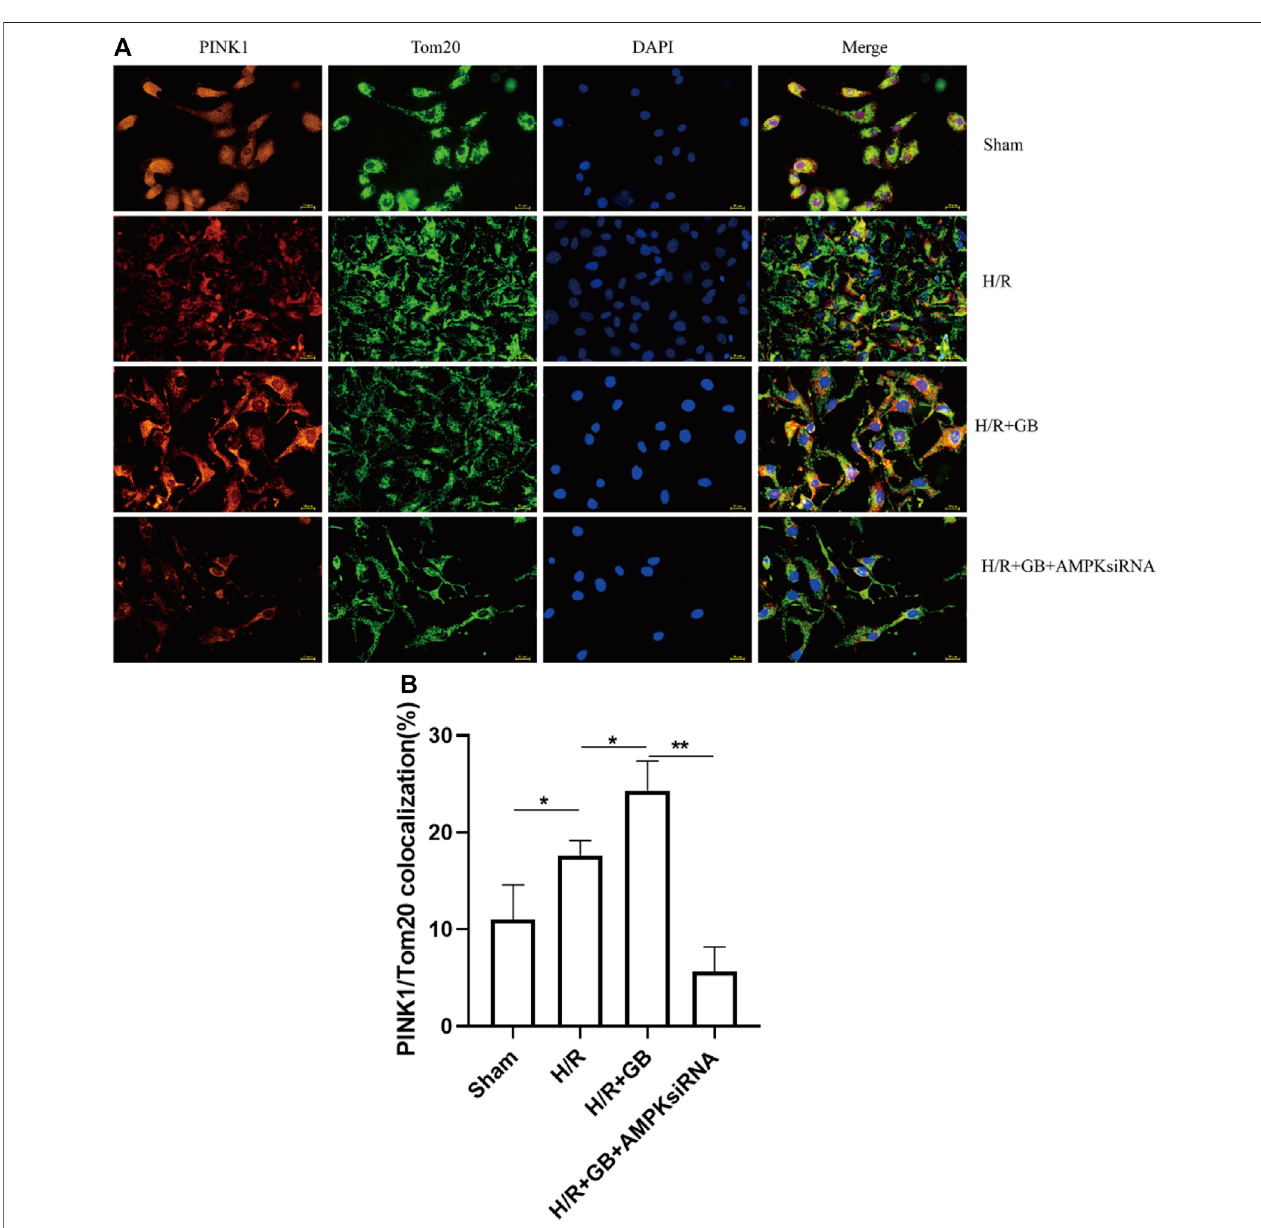
FIGURE 4 | Representative images of PINK1 located on the outer mitochondrial membrane (A) . Bar graphs showing the ratio of PINK1/Tom20 co-localization in the cells subjected to various treatments (B) . Data are expressed as mean ± SEM and represent 3 separate experiments. (* p < 0.05, ** p < 0.01).